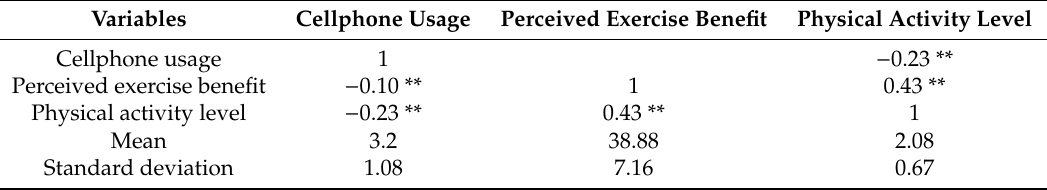
Table 1. Descriptive statistics and correlations between